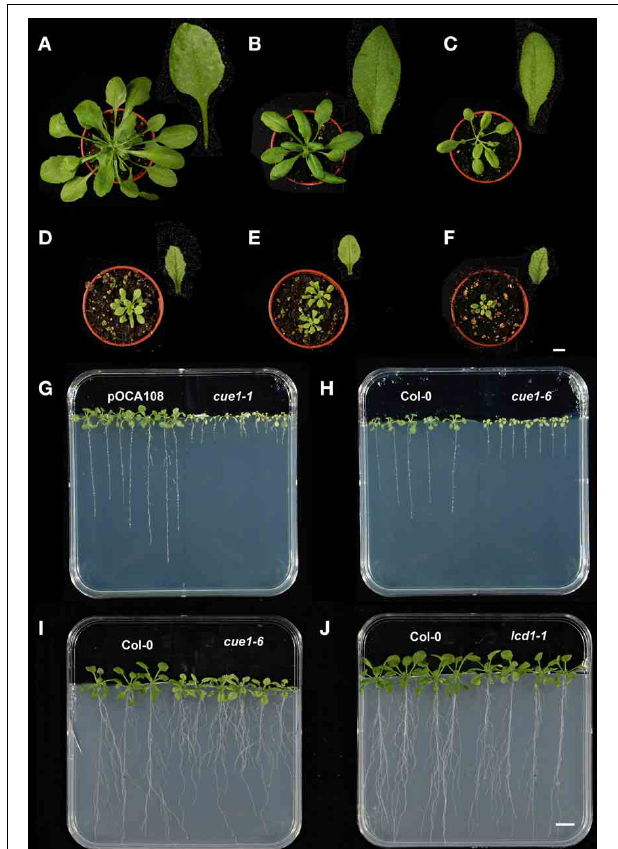
FIGURE 1 | Shoot and root phenotypes of different cue1 alleles and lcd1-1 compared to control plants. Rosettes and leaves of 30 days old pOCA108 (Bensheim) (A) , Col-0 (B) , lcd1-1 (C) , cue1-1 (D) , cue1-1/lcd1-1 double mutants (E) , and cue1-6 (F) , as well as root phenotypes of 21 days old pOCA and cue1-1 (G) , Col-0 and cue1-6 (H) , or 35 days old Col-0 and cue1-6 (I) , and Col-0 and lcd-1 (J) . The bars indicate a length of 1cm referring either to the plants in the pots (A–F) or on agar (G–J)